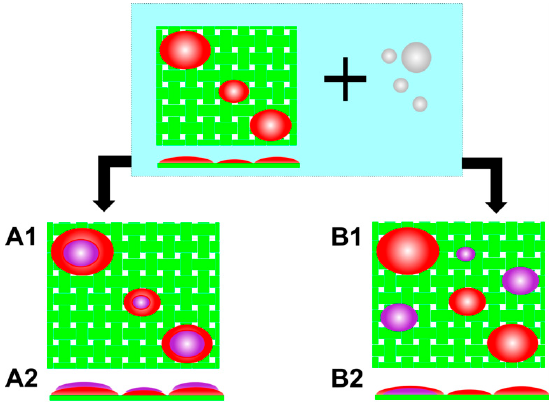
Figure 10. Schematic models for the emergence of distinct mineral superstructures favored via ( A ) mineral-induced or ( B ) organic matrix-induced preferential crystallization of mineral precursors. Crystallization of the amorphous phase (grey) in association with the collagenous matrix (green) or pre-formed crystalline particles (red) lead to distinct mineralization patterns involving subsequent mineral particles (violet). The top-view and side-view are represented by the suffixes 1 and 2, respectively.